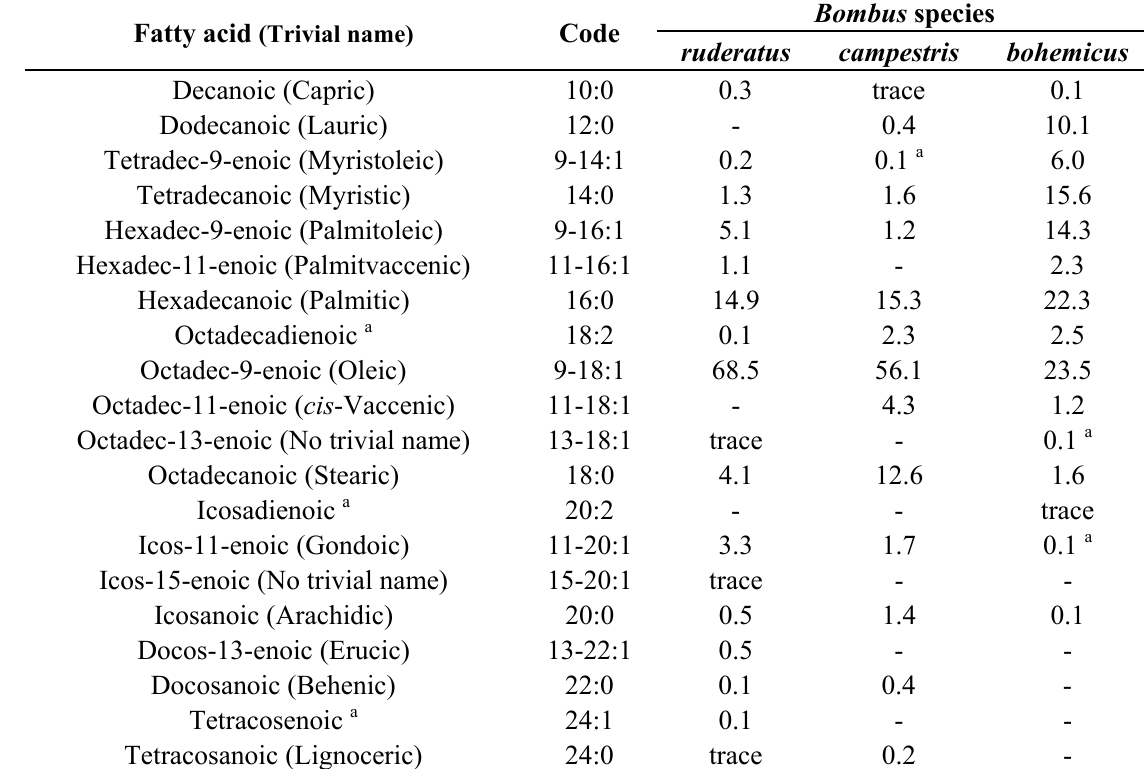
Table 3. Relative proportions (in %) of fatty acids in TG identified after a transesterification of TG fraction from B. ruderatus , B. campestris , and B. bohemicus fat body extracts. Fatty acid (Trivial